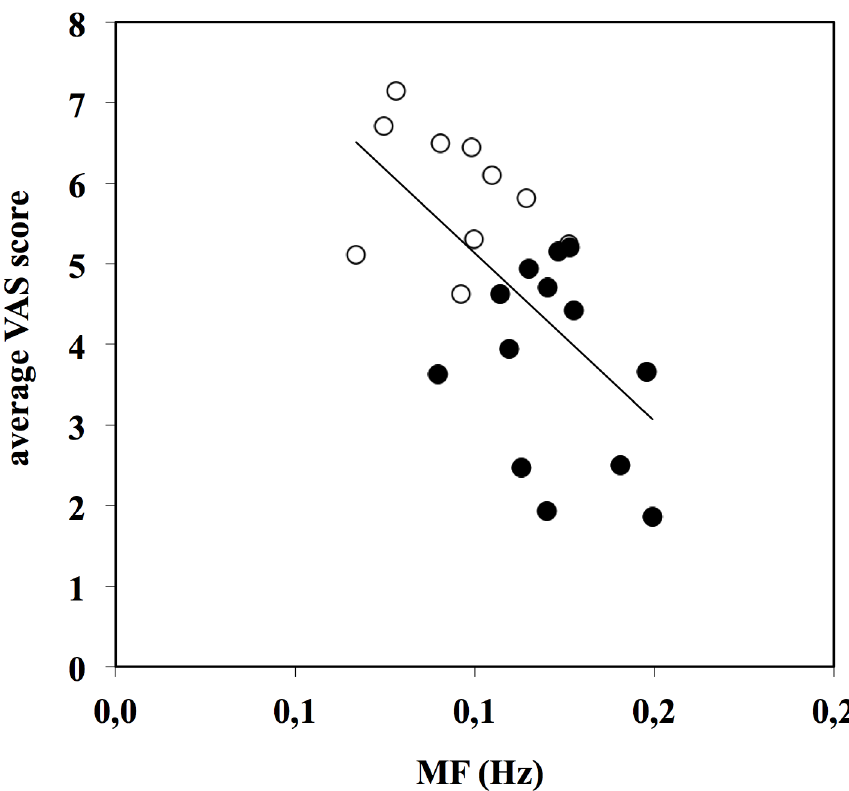
Fig 3. Relationship between VAS score and movement frequency (MF). VAS score = 9.29 – 41.6 (cid:1) MF ( R = 0.609, N = 25, p < 0.001). Data points are the grand averages of the scores given by both expert and non- expert observers for the four investigated movement characteristics (open dots: high-level performance, full dots: middle-level performance).